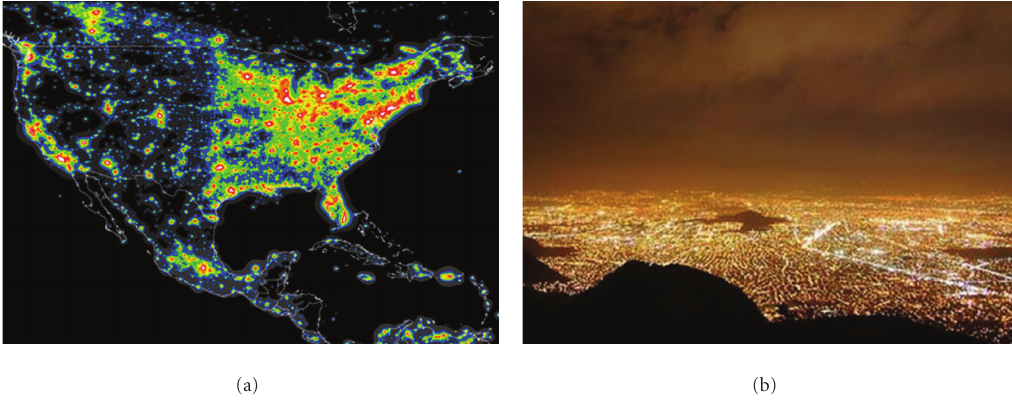
Figure 5: (a) a map of U.S. and Mexico at night, seen from a satellite: red and yellow colors represent up to 200 times the natural level of brightness. (b) an aerial view of Mexico City: note the enormous light pollution (http://www.lightpollution.it/).